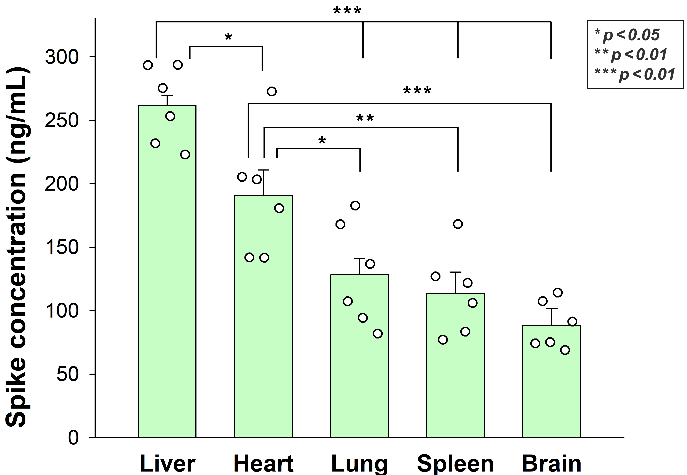
Figure 7. In vivo internalization of inactivated SARS-CoV-2 in mice. C57BL/6 mice were treated with heat-inactivated SARS-CoV-2. After 3 h of incubation, the mice were euthanized, various organs were collected, and their SARS-CoV-2 spike concentration was measured with a spike-specific ELISA kit. Each group contained 6 animals. The bars represent the mean + SEM. Statistical significance was assessed with ANOVA. * p < 0.05; ** p < 0.01; *** p < 0.001.